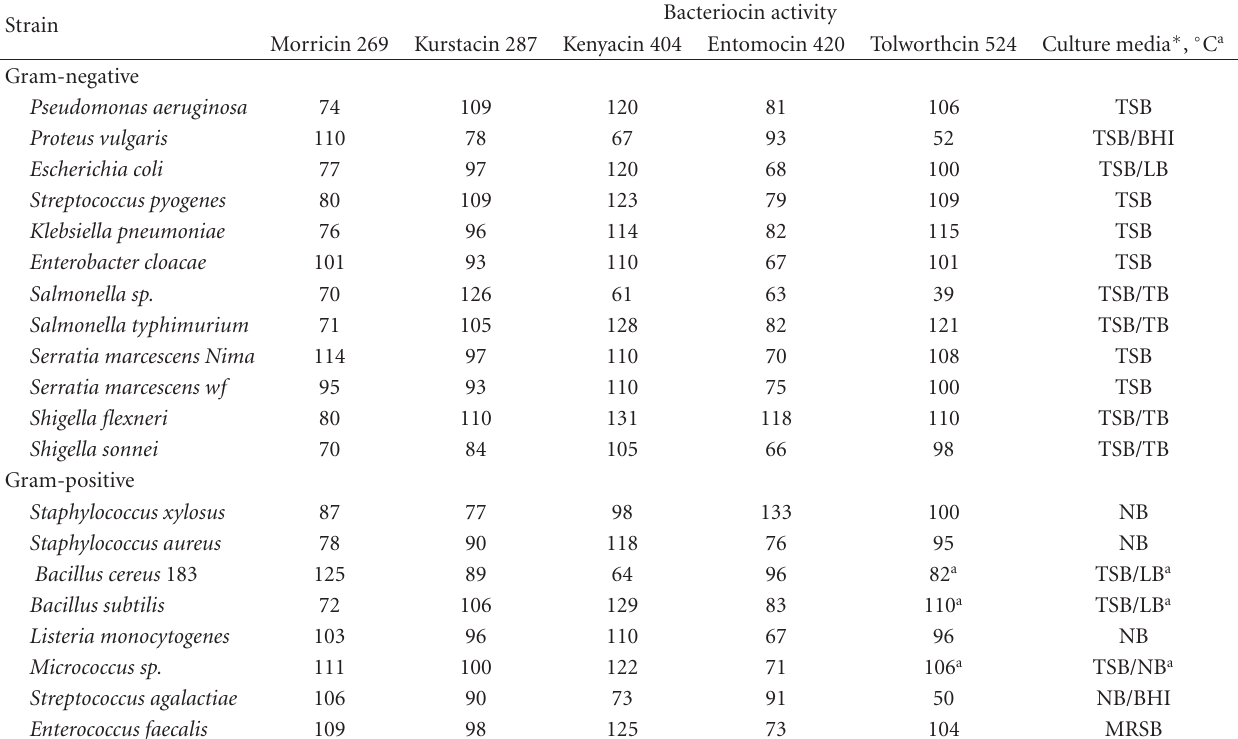
Table 2: Inhibitory activity (UF) of bacteriocins synthesized by B. thuringiensis determined by fluorogenic method.